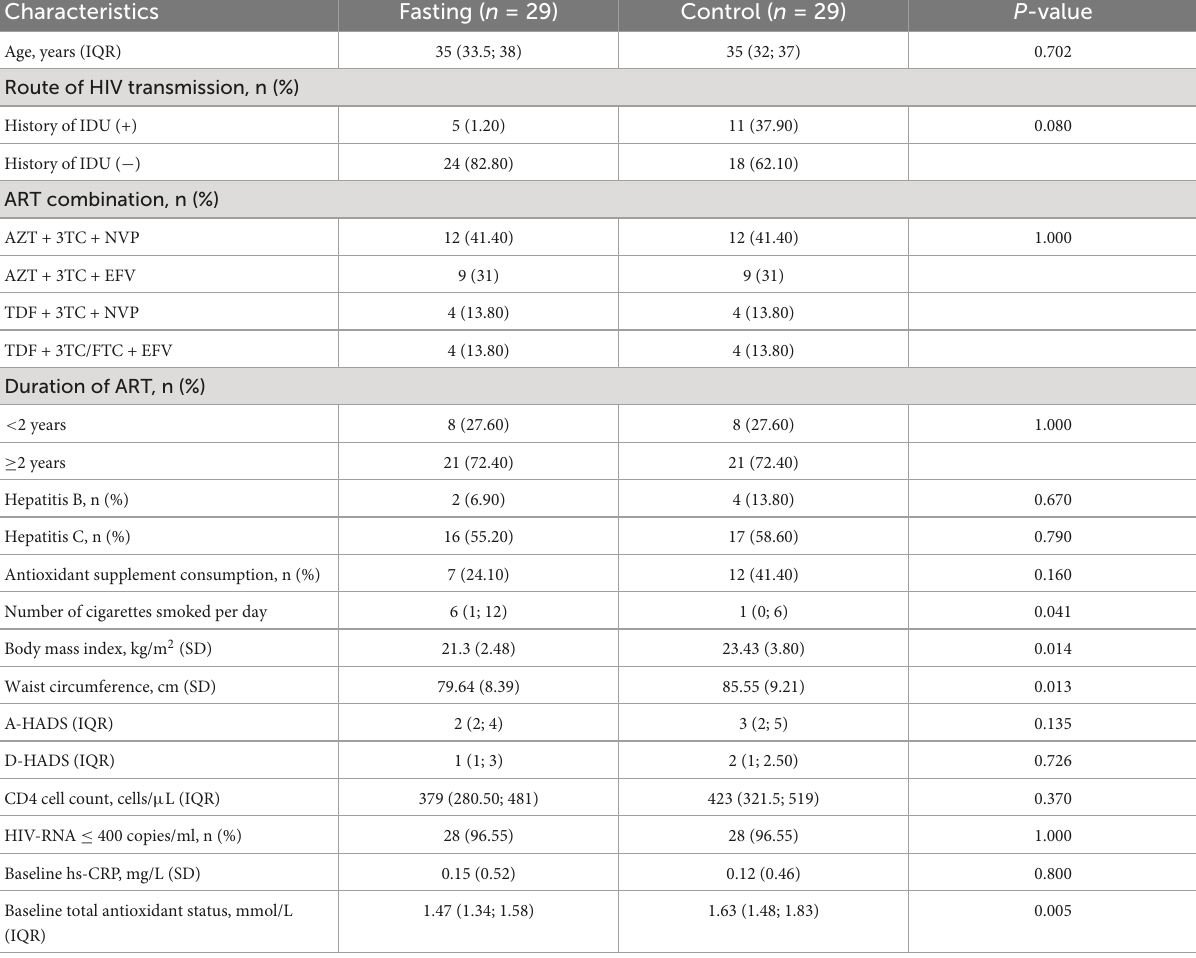
TABLE 1 Baseline characteristics of the fasting and control groups.